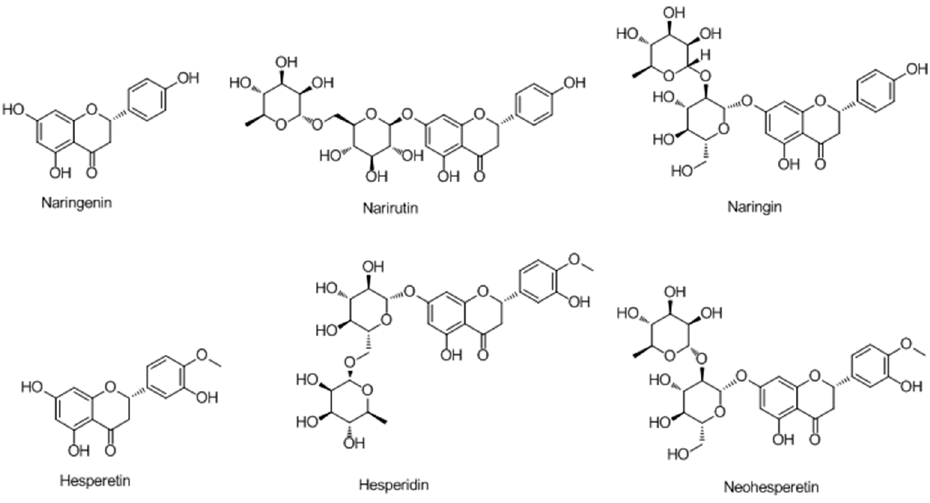
Figure 4. Structures of flavanones isolated from Citrus .